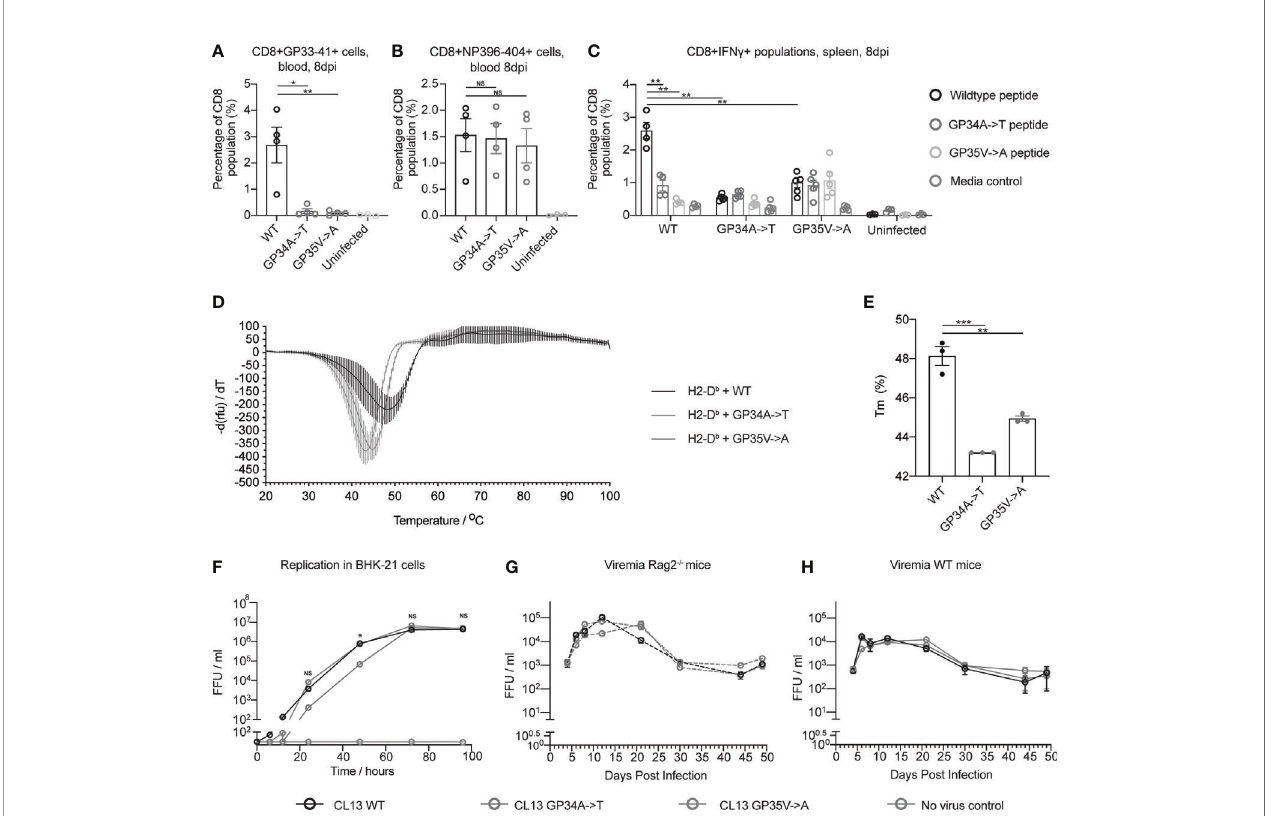
cytokine staining at 8 days post infection and analysed with fl ow cytometry. Splenocytes were gated for the Lymphocyte/Single cell/Live/CD3+CD8+ population before being analyzed for IFN g expression. Splenocytes from each mouse were stimulated with either GP33-41 WT peptide or peptide either containing the